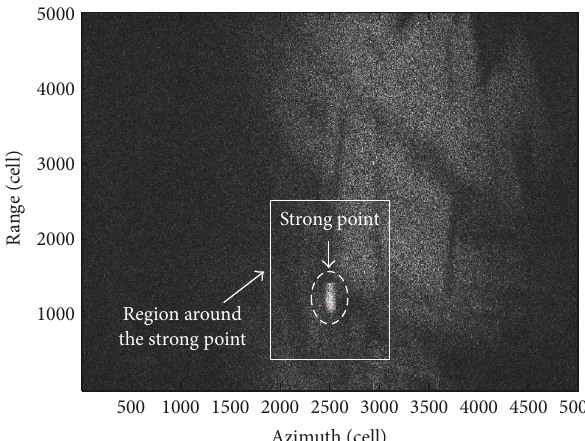
Figure 9: Track of a strong point in range-compressed echo (bistatic radar). The amount of RCM is much larger than that in the monostatic SAR.